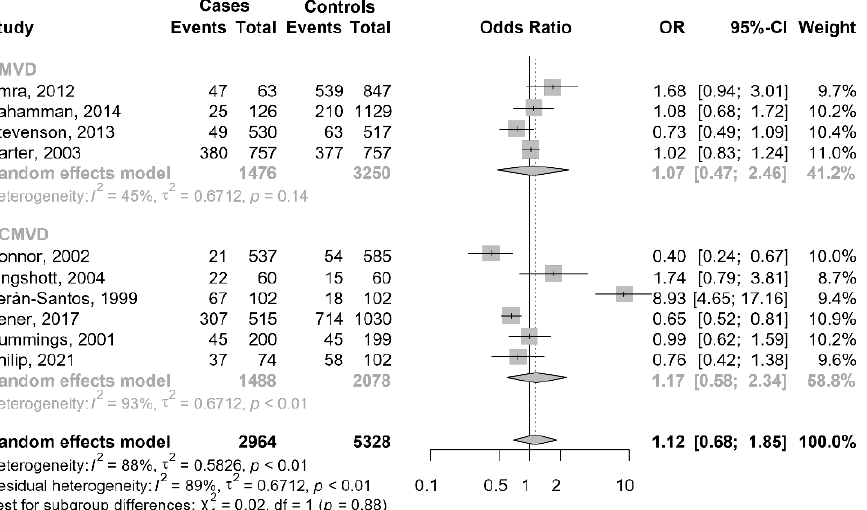
Figure 6. The forest plot of the subgroup meta-analysis of car accidents and non-car accidents with OSAS based on types of drivers [23,28,42,49,51,54,55,59–61]. Events Cases are defined as car accidents with OSAS (total of 1000) and Total Cases as car accidents (2964); Events Controls are defined as non-car accidents with OSAS (total 2093) and Total Controls as non-car accidents (5328). In each group, a diamond represents the pooled OR estimate based on the random effects model.